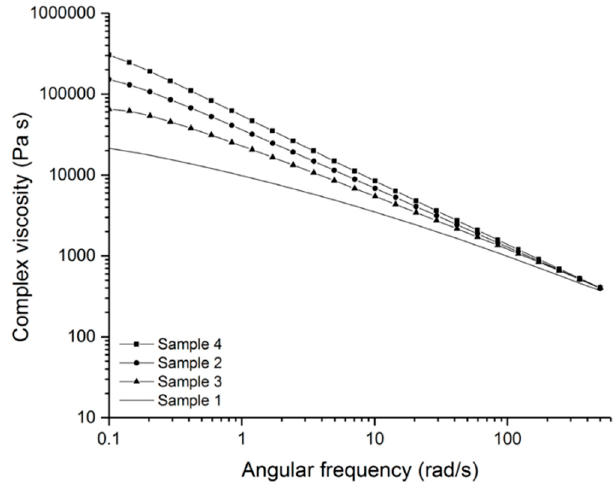
Figure 5. Complex viscosity of the crosslinked samples (sample 2–4) and the non-crosslinked sample (sample 1).